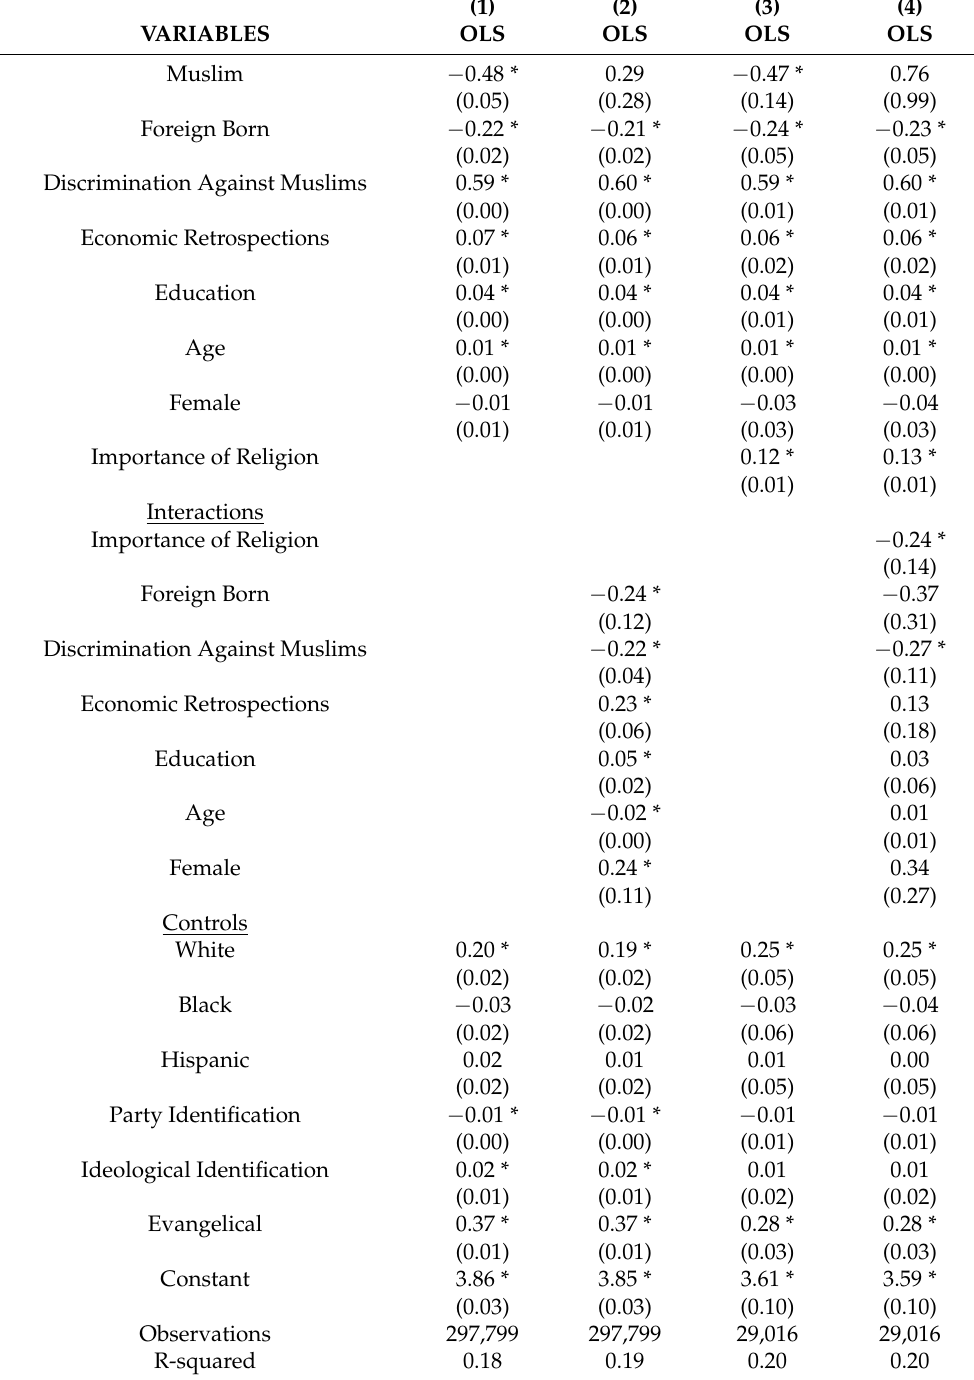
Table 1. Sources of Variation in American Muslim Attitudes toward